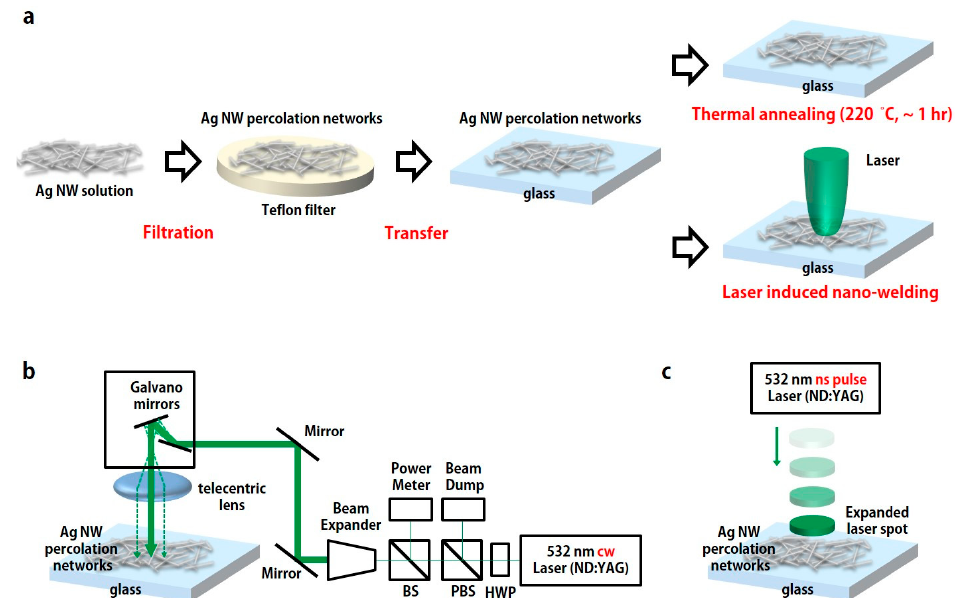
Figure 1. Schematic diagram of the thermal annealing process and laser-induced nano-welding process for Ag nanowires (NWs) percolation networks. ( a ) Sample preparation flow chart. Firstly, Ag NWs are synthesized in a solution by polyol synthesis. Afterwards, they are filtered on the Teflon filter and transferred onto the glass substrate to form Ag NW percolation networks on glass substrate.